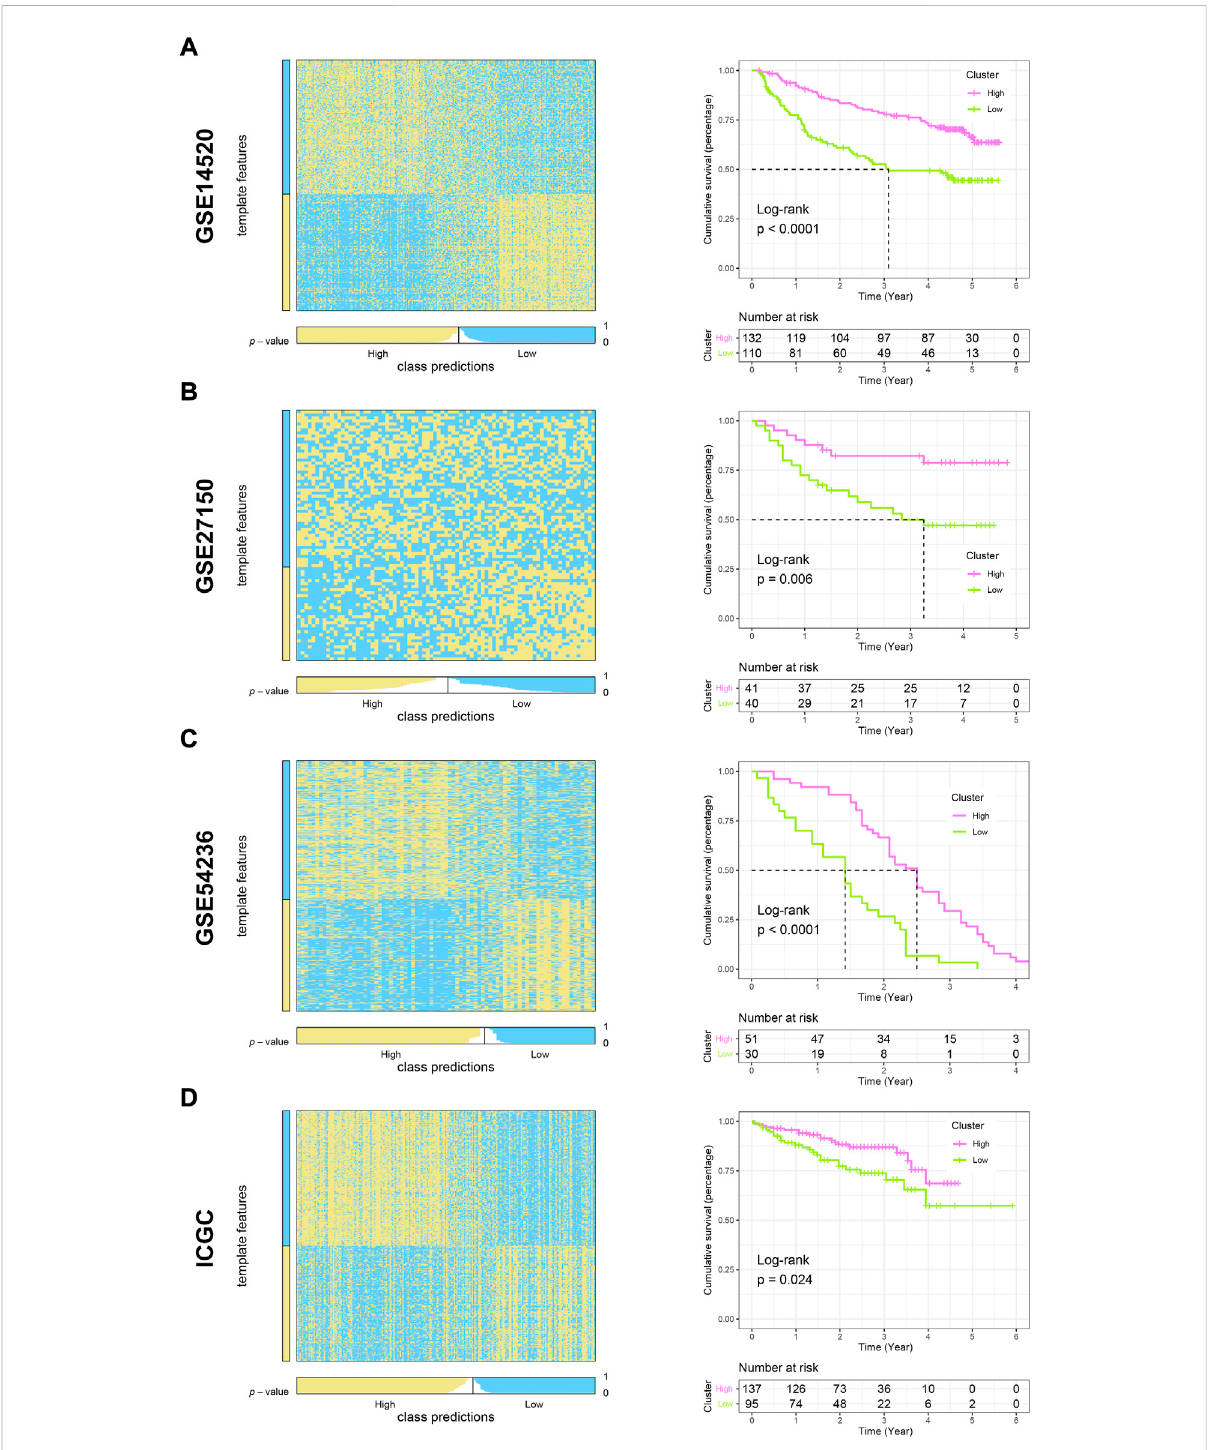
FIGURE 6 Validation of high- and low-m6Ascore grouping using the NTP algorithm and exploration of prognostic differences in other cohorts. (A – D) Heatmaps and K-M curves showing predicted patient distribution and prognostic differences for liver cancer in GSE14520, GSE27150, GSE54236, and ICGC cohorts,